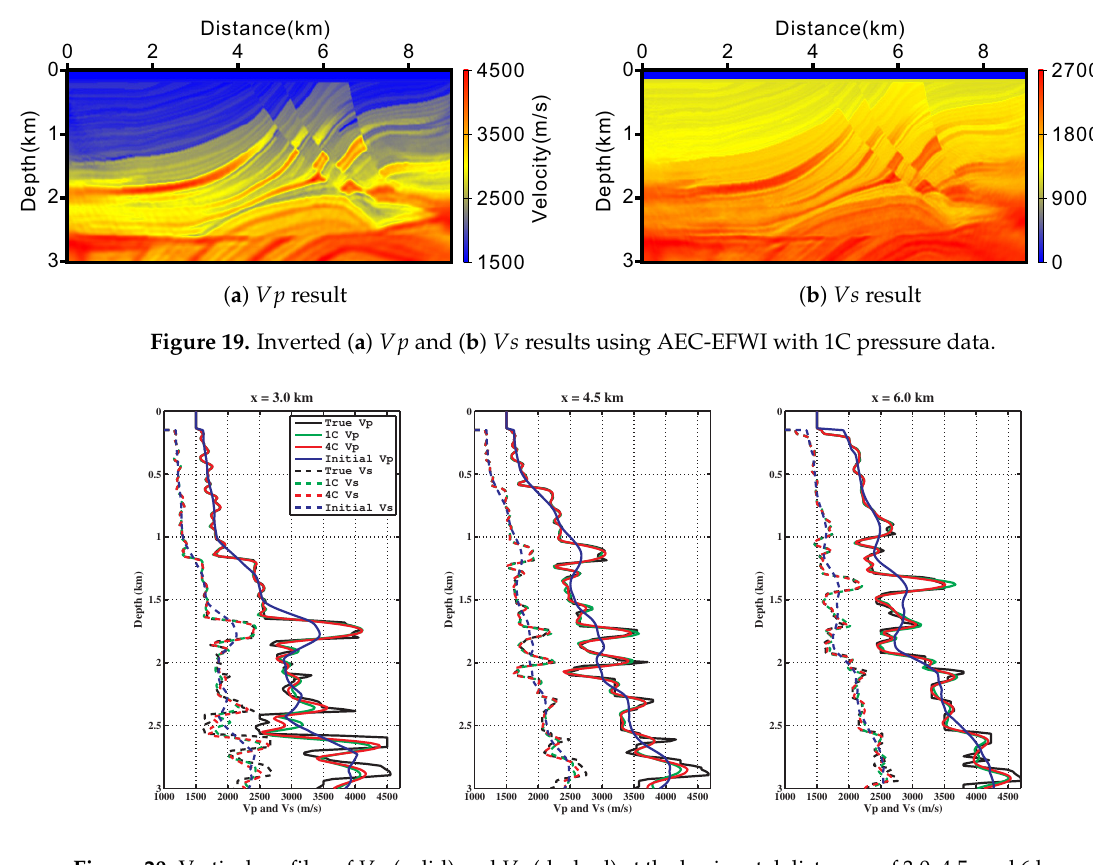
Figure 20. Vertical profiles of Vp (solid) and Vs (dashed) at the horizontal distances of 3.0, 4.5, and 6 km.